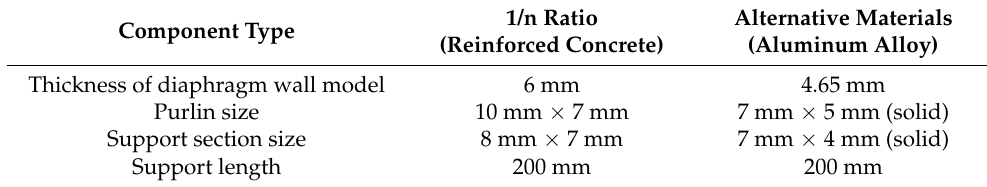
Table 2. Converted model size.